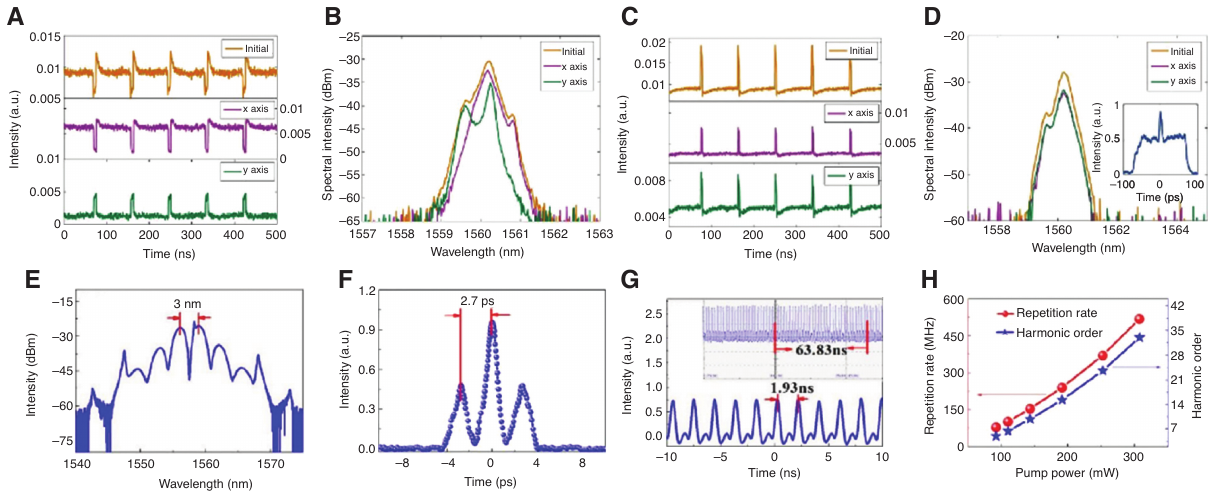
Figure 17: Versatile soliton pulse generated with layered 2D materials. (A–E) Bi Te . (A) Bright-dark pulse traces before (initial) and after (x-axis and y-axis) passing through PBS. (B) Bright-dark pulse optical spectra 2 3 before (initial) and after (x-axis and y-axis) passing through PBS. (C) Pulse traces of fundamental noise-like pulses before (initial) and after (x-axis and y-axis) passing through the PBS. (D) Corresponding optical spectra (inset: autocorrelation trace of the total pulse). Reproduced with permission from Ref. [446]. Copyright 2016, Springer Nature. (E–H) MoS based bound-state soliton mode-locked fiber laser. (E) Optical 2 spectrum. (F) Autocorrelation trace. (G) Bound-state pulse oscilloscope trace with a pump power of 307 mW. (H) Repetition rate and harmonic number under a different pump power. Reproduced with permission from Ref. [333]. Copyright 2018, Optical Society of